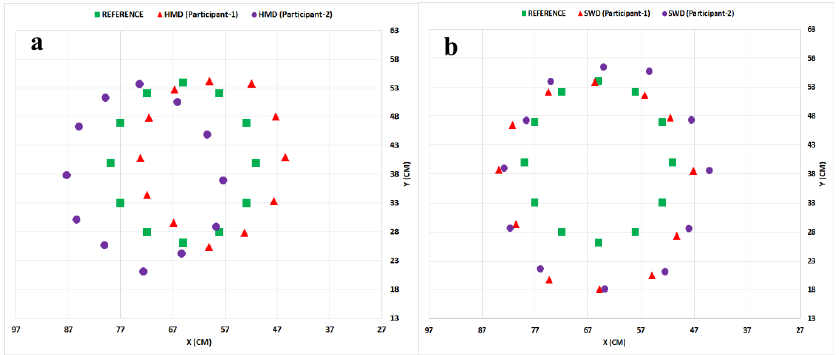
Figure 7. A representative sample result of two participants showing how the estimates with respect to the reference at 65 cm distance from participants were observed. The positions judgment ( a ) in the HMD, a systematic shift to the right or to the left was observed. The way the HMD lens fit to the to the participant’s eye might be the possible reason for the observed result. However, ( b ) in the SWD, there was no systematic shift to any of the directions, instead, consistent estimates and overestimations were observed.